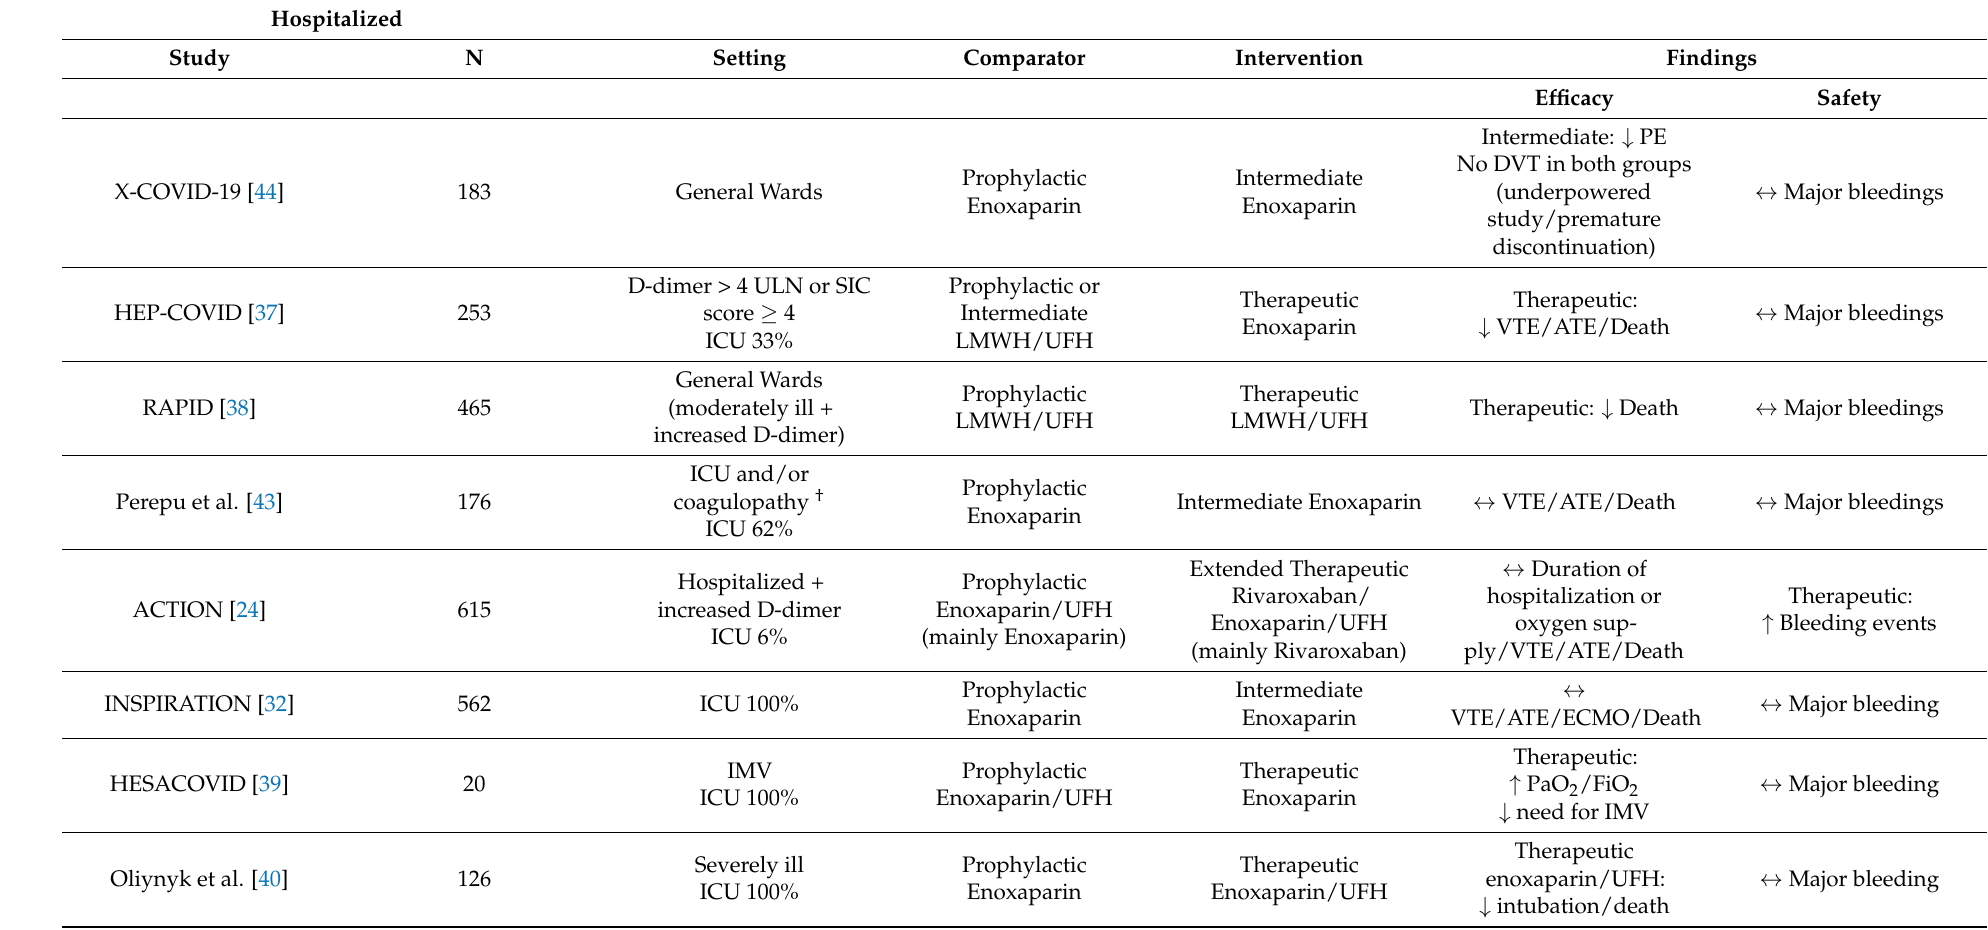
Table 1. Randomized Controlled Trials regarding thromboprophylaxis strategies in patients with